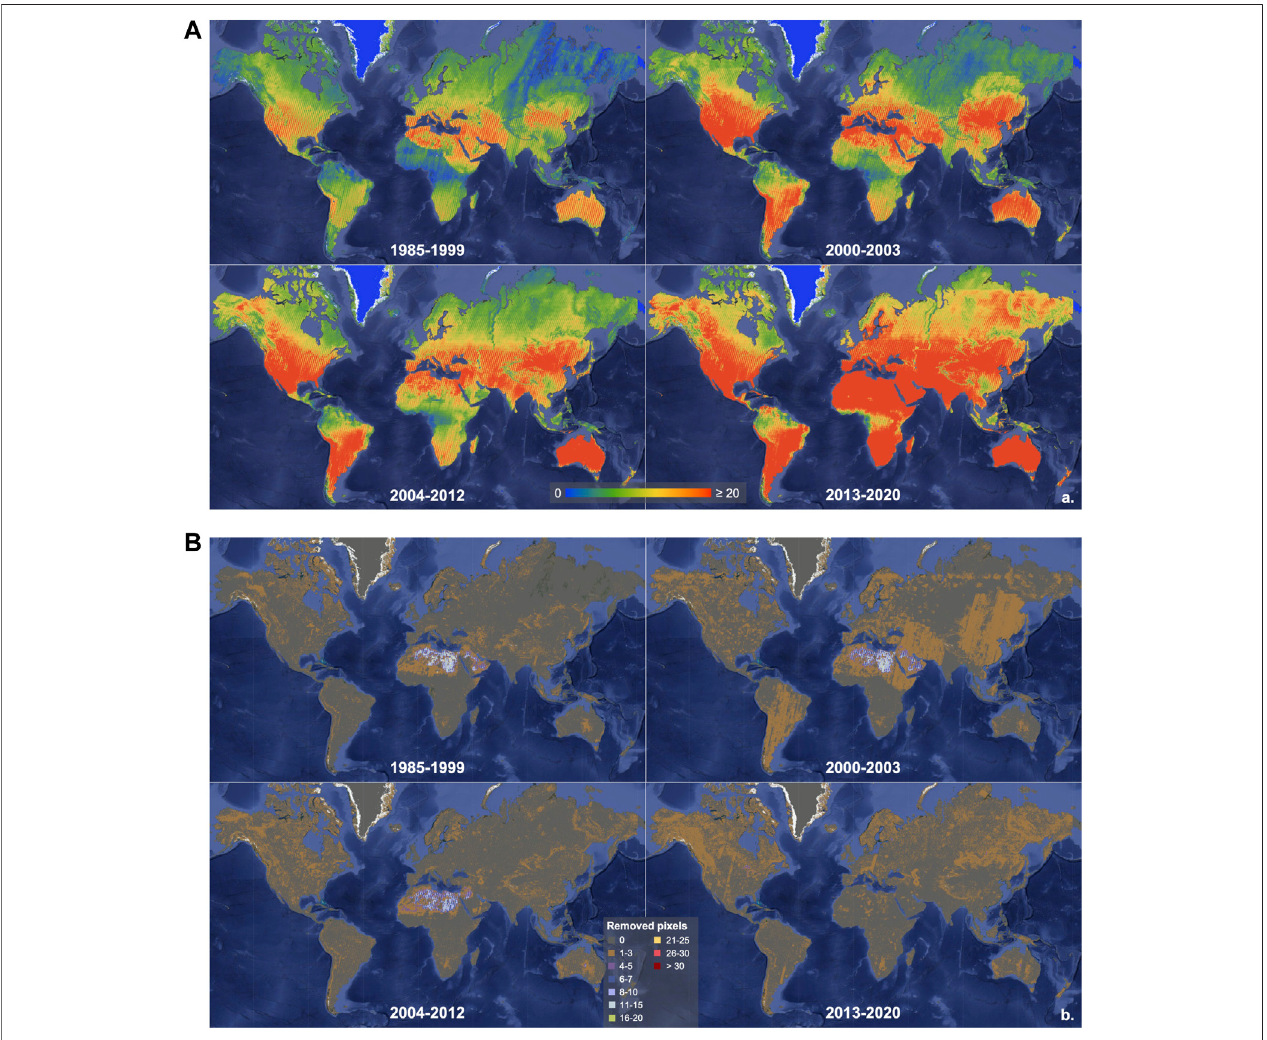
FIGURE 3 | (A) Average number of observations per year, fi ltered out cloud, cloud shadow, snow, saturated, and unrealistic SR pixels. (B) Average number of observations removed per year by fi ltering pixels with unrealistic SR and saturation. The difference is between maps in Figures 2A , 3A .